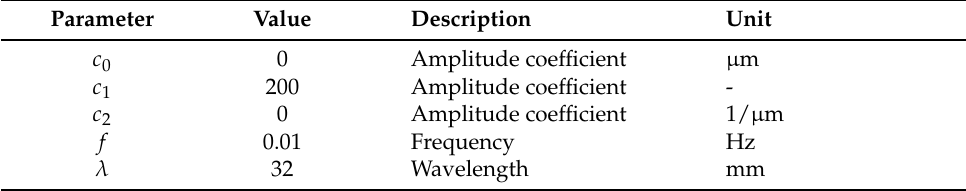
Table 4. Linear Carangiform waveform